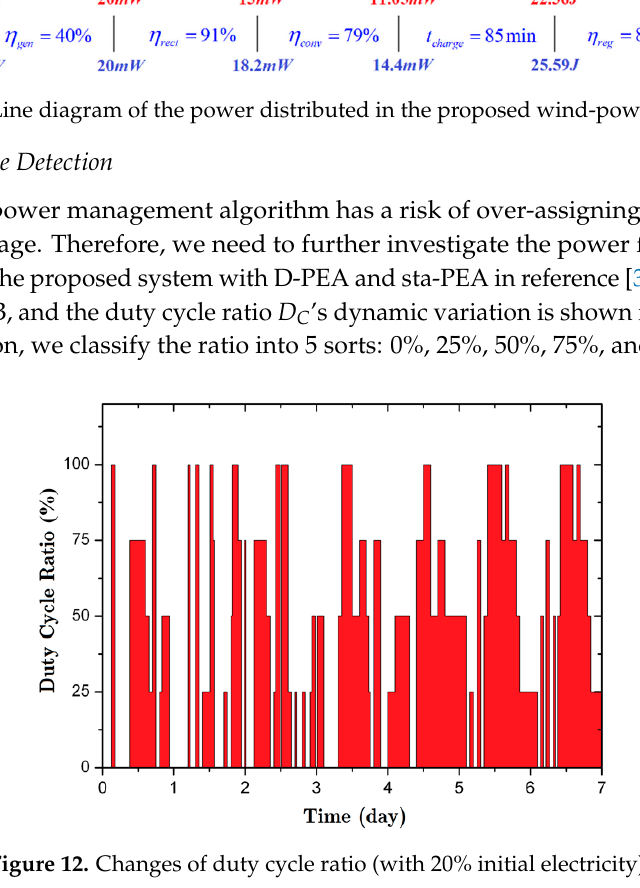
Figure 13. Power failure time